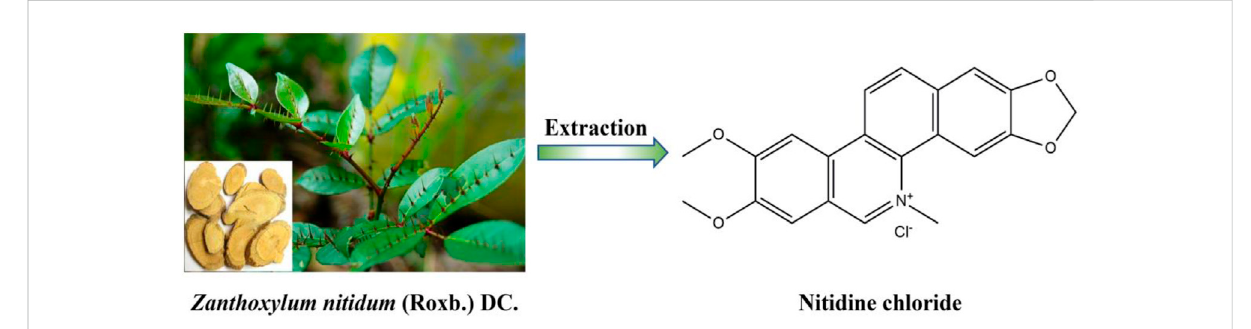
FIGURE 1 Origin plant and chemical structure of nitidine